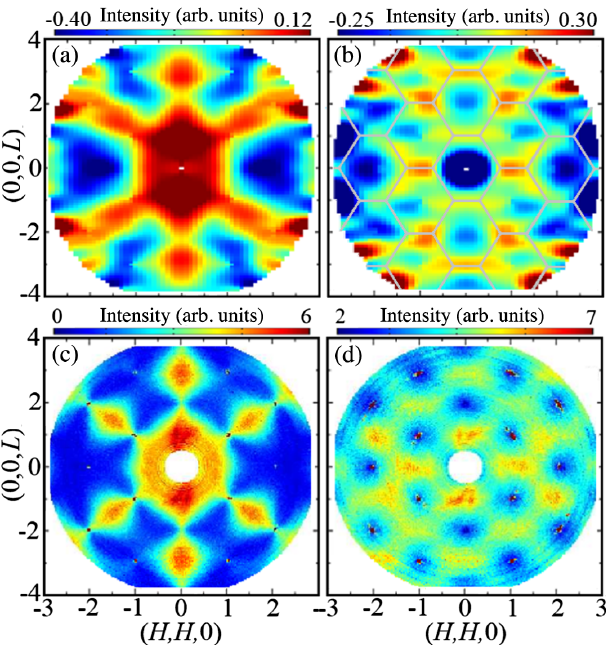
FIG. 2. The symmetrized T ¼ 45 mK − T ¼ 10 K tempera- ture-difference neutron signal measured in the (a) SF and (b) NSF channels of our polarized neutron diffraction experiment on Ce 2 Zr 2 O 7 . The (c) SF and (d) NSF scattering signals in the ½ HHL (cid:2) plane measured in a polarized neutron scattering experi- ment on Ho 2 Ti 2 O 7 at T ¼ 1 . 7 K [13]. The data in this figure are shown in arbitrary